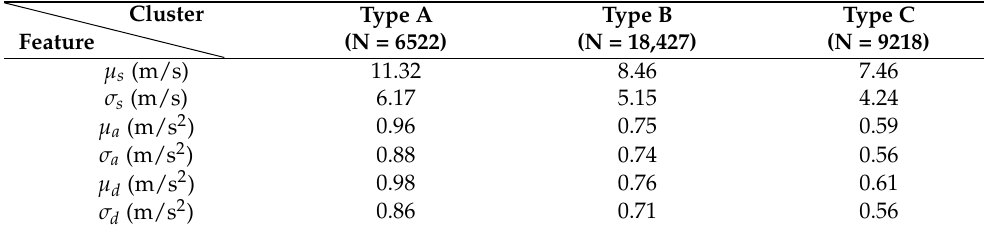
Table 4. Clustering results of driving styles (cluster